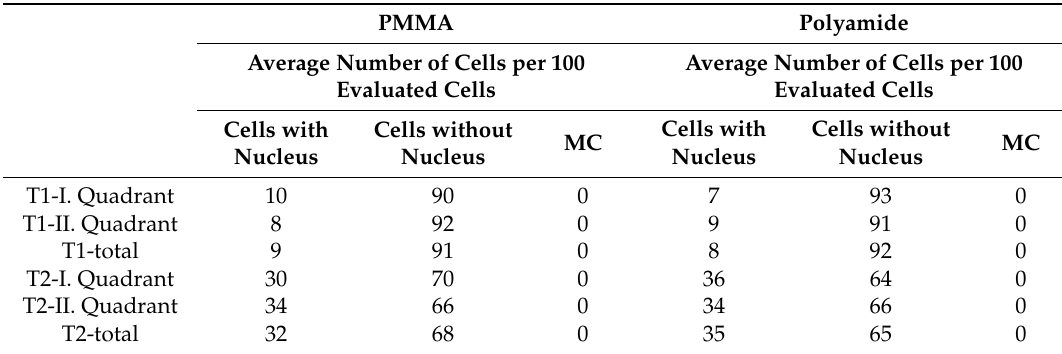
Table 3. Results of